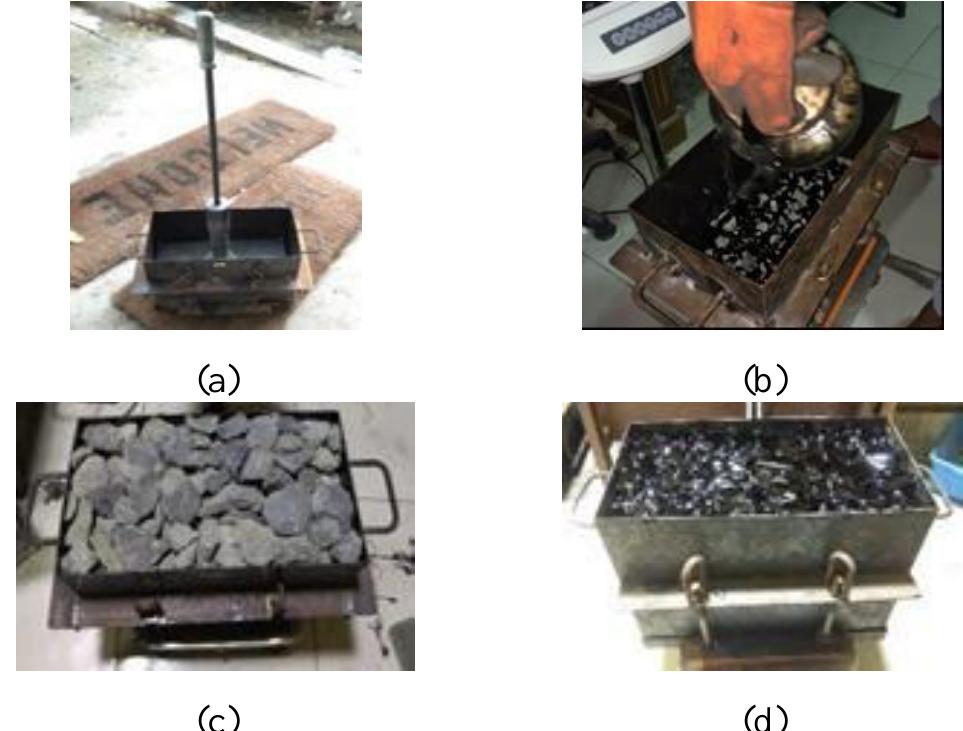
Figure 1: (a) Compaction process; (b) asphalt pouring process; (c) specimens without asphalt mixture; (d) specimens with asphalt mixture